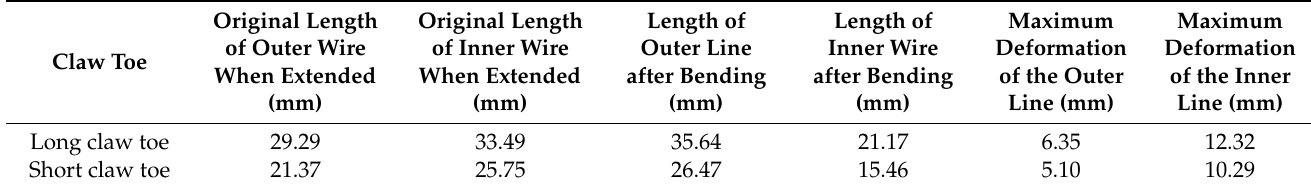
Table 1. Deformation of articulated long and short claw toe fishing lines.